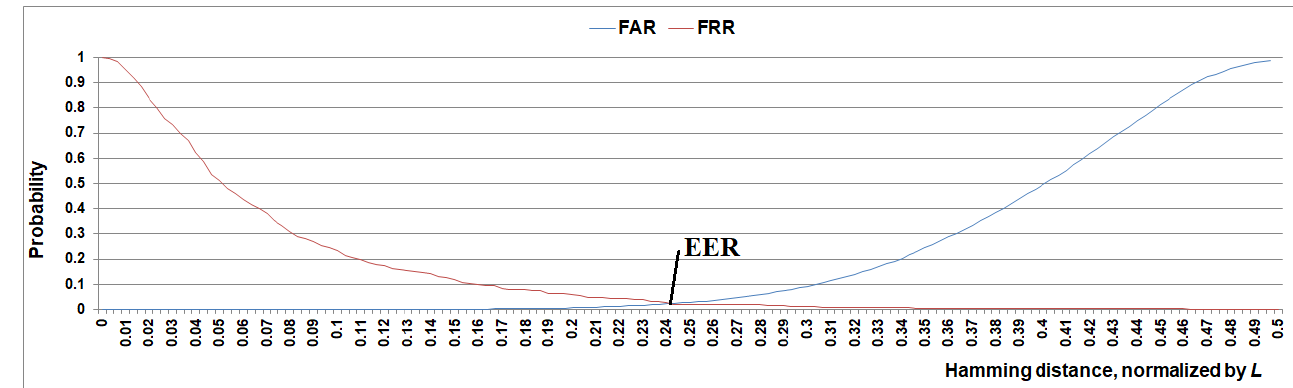
Figure 12. Results of user verification using two ears at C + = 0.5, C - = 0.5, AUC MAX = 0.3, K G = 6, N = 4096, η = 5. Table 7. Results of personality recognition by the ear echographic.